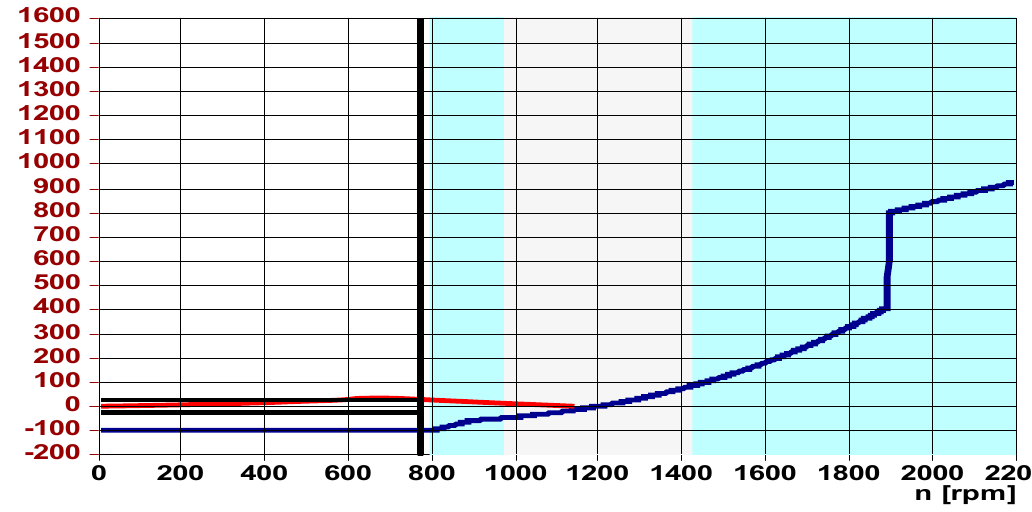
Figure 20. A wind turbine based on DFIG with a speed of 3.4 m/s.